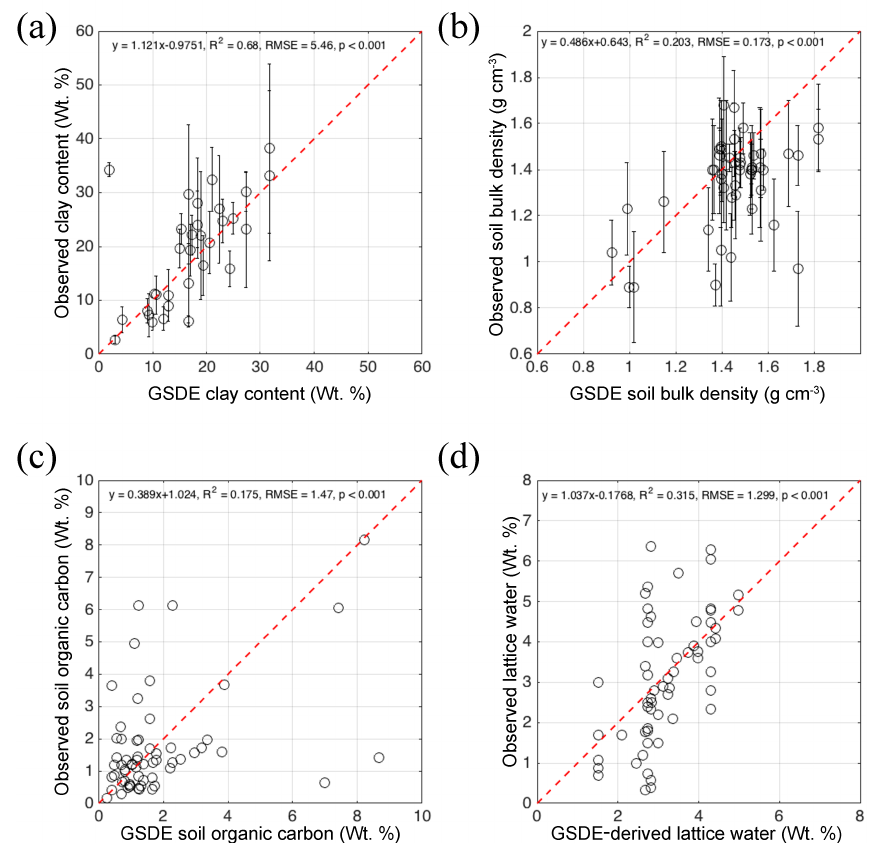
Figure 2. Comparison between 61 in situ composite samples and GSDE values from the closest pixel for (a) clay weight percent, (b) soil bulk density, and (c) soil organic carbon. (d) Comparison between in situ lattice water and derived values using GSDE clay weight fraction and soil taxonomic orders. See Table 1 for summary of data by taxonomic group, Table S1 for raw data, and Table 2 for statistical summary of differences between in situ and GSDE products. Note error bars denote ± 1SD (standard